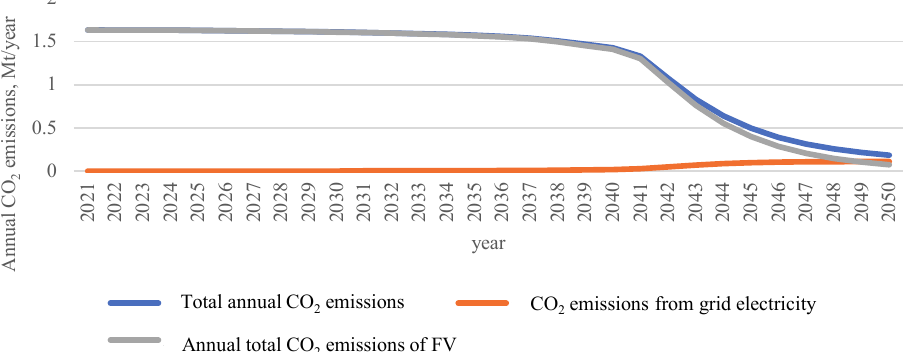
Fig. 3. Annual CO 2 emissions: the total, from fossil fuel – based vehicles and from grid electricity.